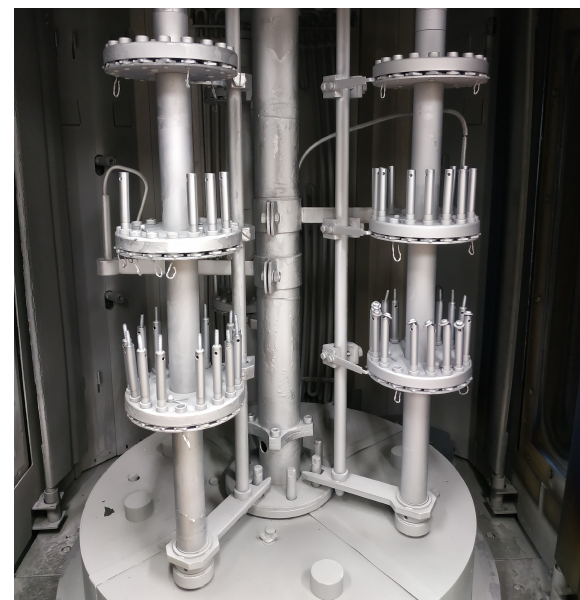
Figure 2. The chamber of the Hauzer Flexicoat 850 coating